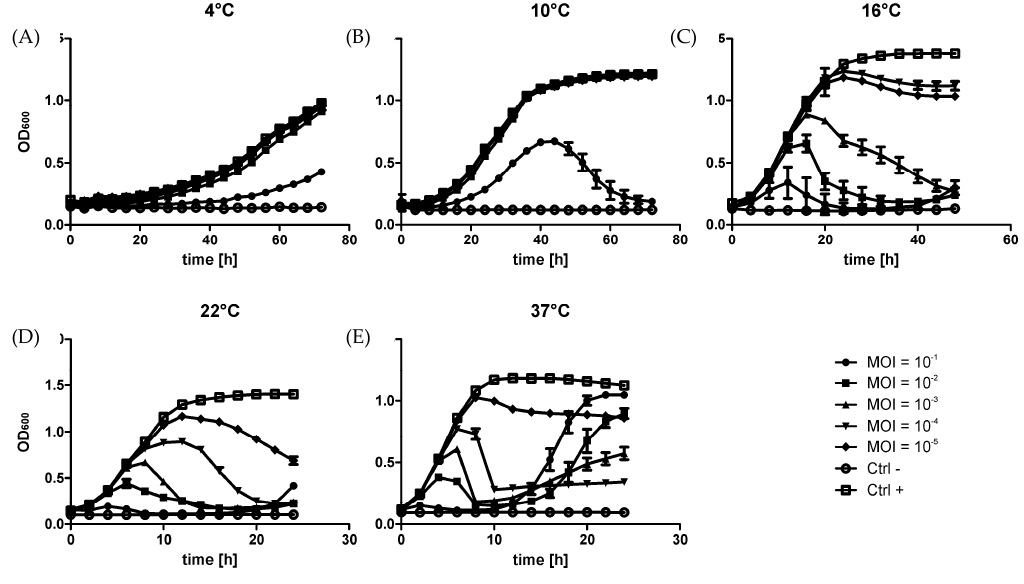
Figure 1. Growth curves of YeO3 ‐ R1 bacteria at different temperatures when infected with phage φ R1 ‐ 37. Bacteria infected with phage φ R1 ‐ 37 at MOIs of 10 − 1 to 10 − 5 were grown in LB at 4 °C ( A ), 10 °C ( B ), 16 °C ( C ), 22 °C ( D ), and 37 °C ( E ). Each data point in the graphs represents the average of eight replicates. The error bars represent the standard deviation for the optical density calculated for each time point. Note the different axis scales in the different panels.